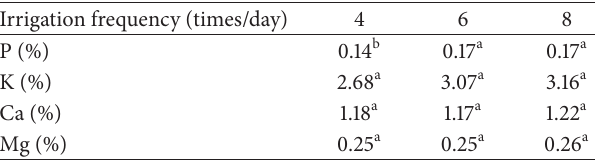
Table 6: Effect of irrigation frequencies on phosphorus, potassium, calcium, and magnesium level in leaves of chrysanthemum at 14 weeks after transplanting.